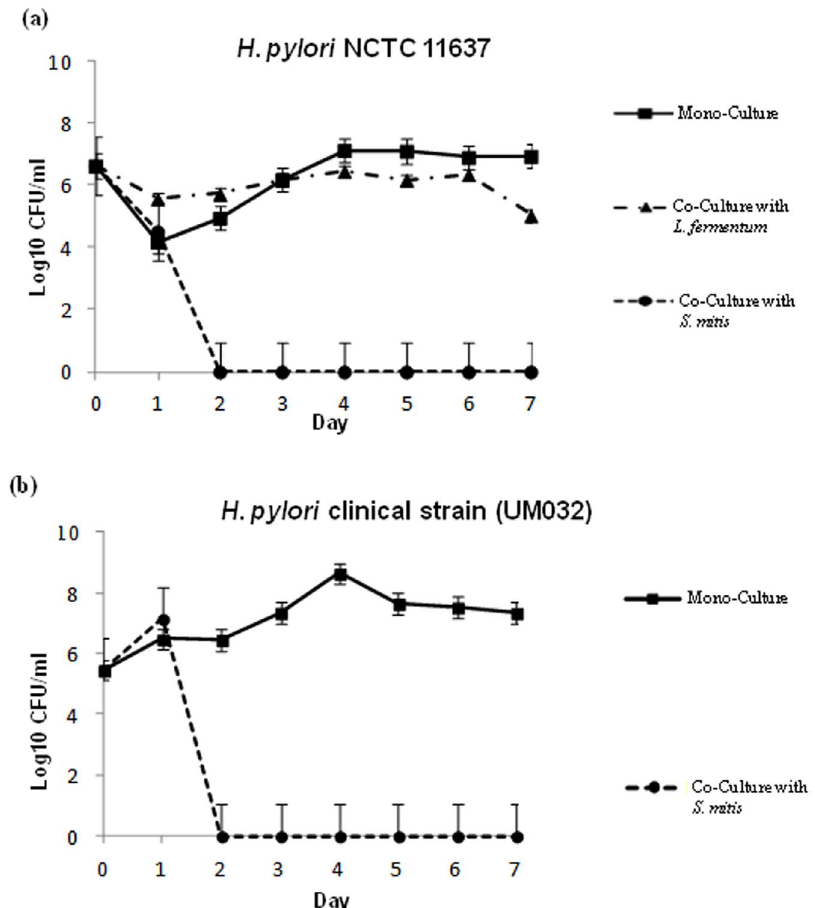
Figure 2. Effect of S.mitis and of L.fermentum on H.pylori growth during co-culture. H. pylori reference (NCTC 11637, (a)) and clinical (UM032, (b)) strains were grown alone or co-cultured with S. mitis or with L. fermentum . At the times indicated, colony forming unit of H. pylori were calculated by plating dilutions of the cells onto chocolate-agar plates. Each point shows the means and standard deviation of triplicated experiments.